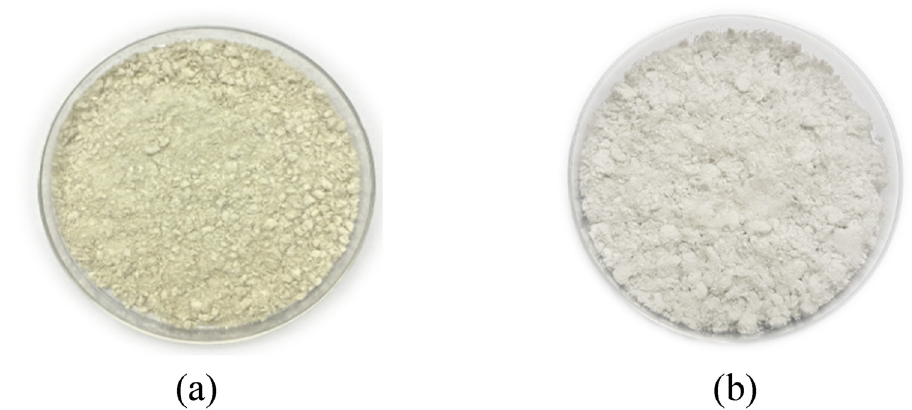
Figure 4: ( a ) Microcrystalline cellulose ( MCC ) and ( b ) nanocrystalline cellulose ( NCC ) derived from pineapple